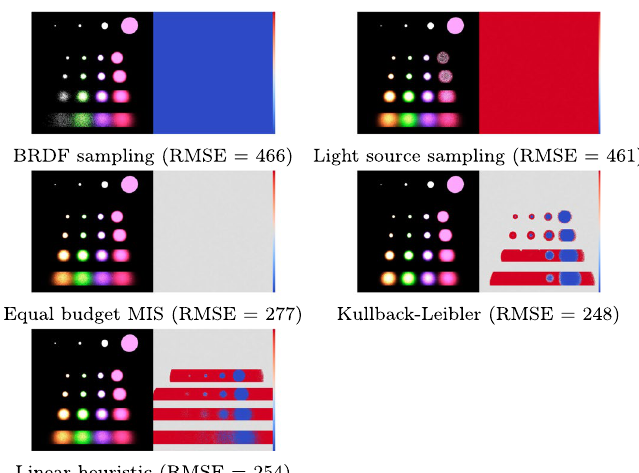
Fig. 19 Comparison of MIS weighting schemes for the direct lighting problem of computer graphics. The left part is the image rendered with 100 rays per pixel, the right part is weight α of the light source sampling. The RMSE is computed as the average of 10 independent executions. The [0,1] interval of possible α values is visualized by the color